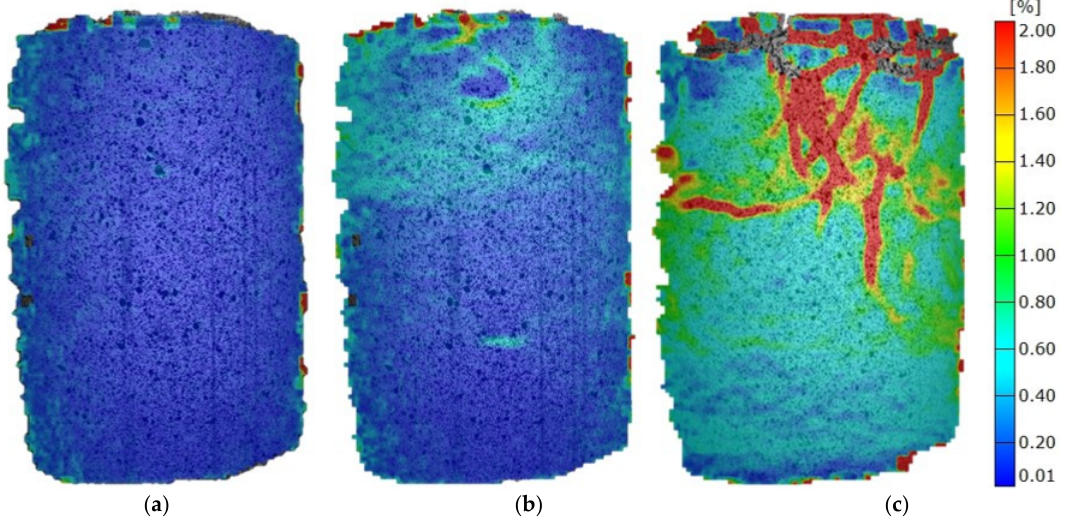
Figure 10. Mises strain at various load stages of mixtures with lime. ( a ) 0.3 F max ; ( b ) 0.6 F max ; ( c ) 1.0 F max .